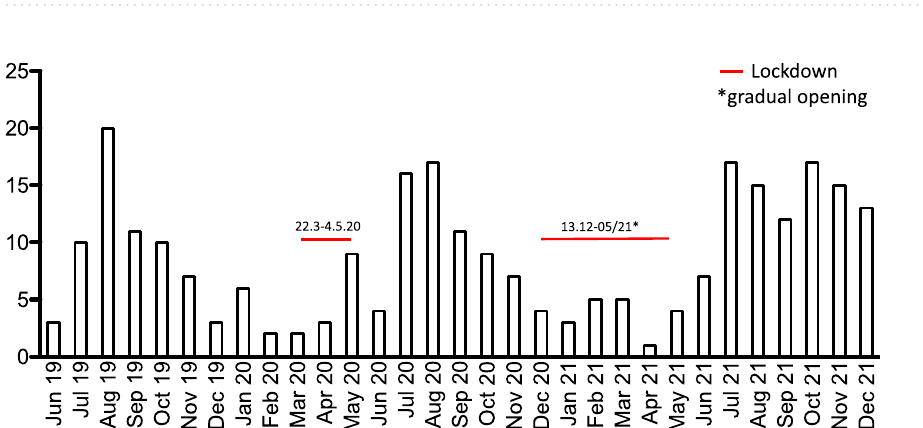
Figure 1. Graph depicting e-scooter associated ED presentations and effect of Covid-19 lockdown on number of